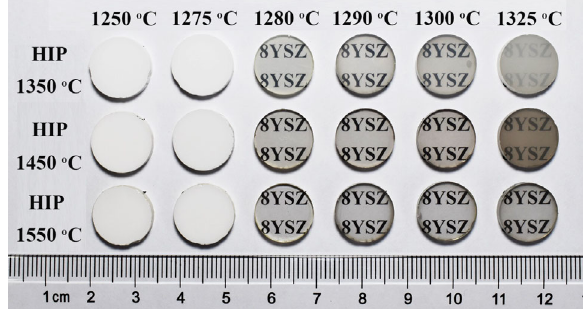
Fig. 5 Photographs of the 8YSZ ceramics (2.5 mm in thickness) pre-sintered at 1250–1325 ℃ for 4 h in air and then HIP post-treated at 1350, 1450, and 1550 ℃ for 3 h under 176 MPa